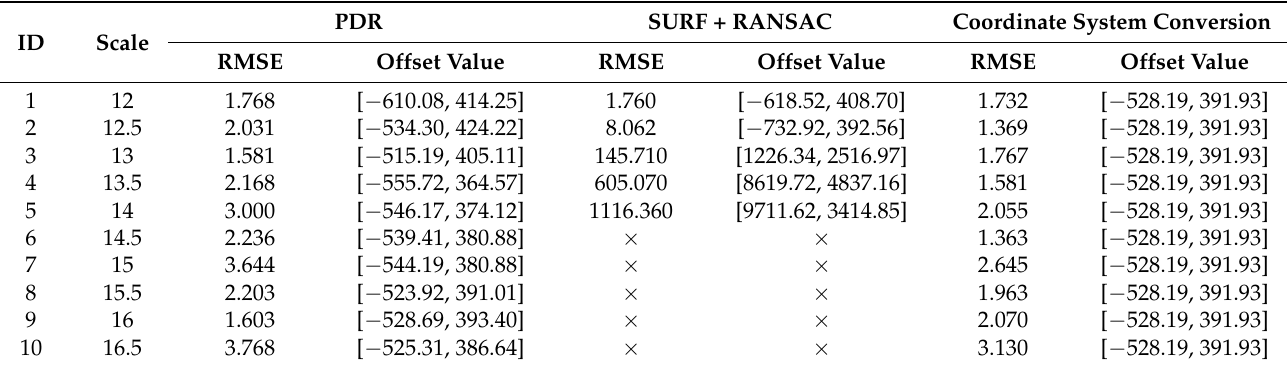
Table 5. Registration results of three methods in vector maps of Ganzhou.